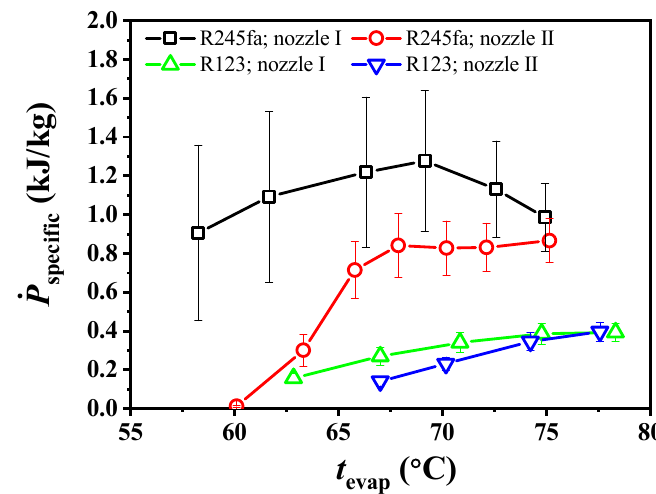
Figure 7. Variation of specific energy with evaporating temperature. Figure 7 . Variation of specific energy with evaporating temperature.